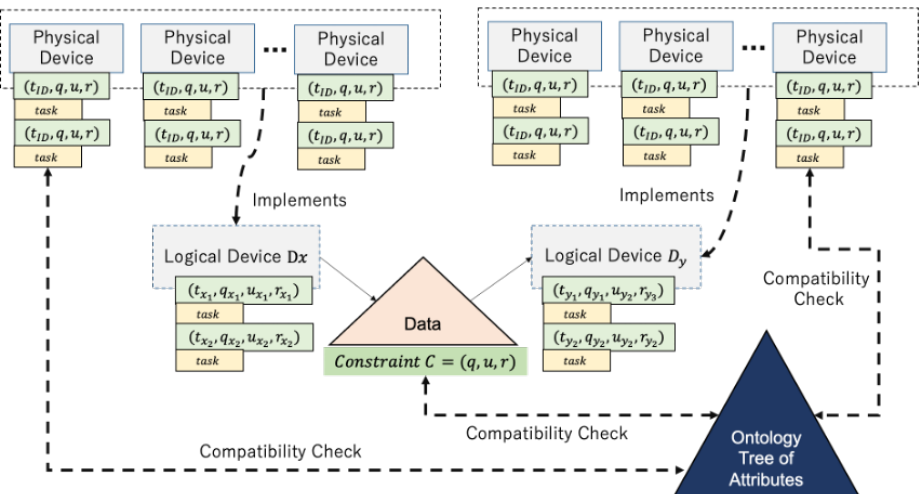
Figure 3. Overview of the proposed